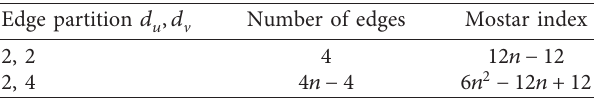
Table 23: Edge partition of para chain of even